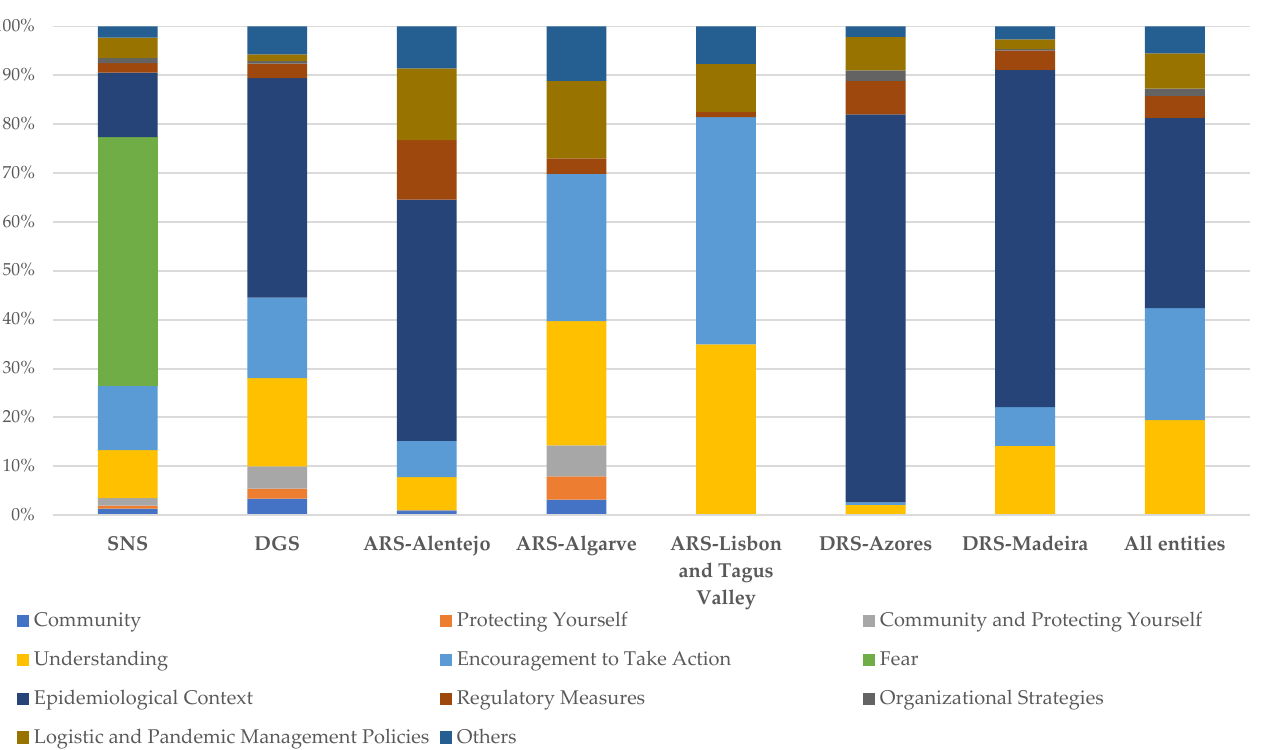
Figure 2. Emerged themes from the thematic analysis of health entities’ posts on Facebook, Instagram, and Twitter.